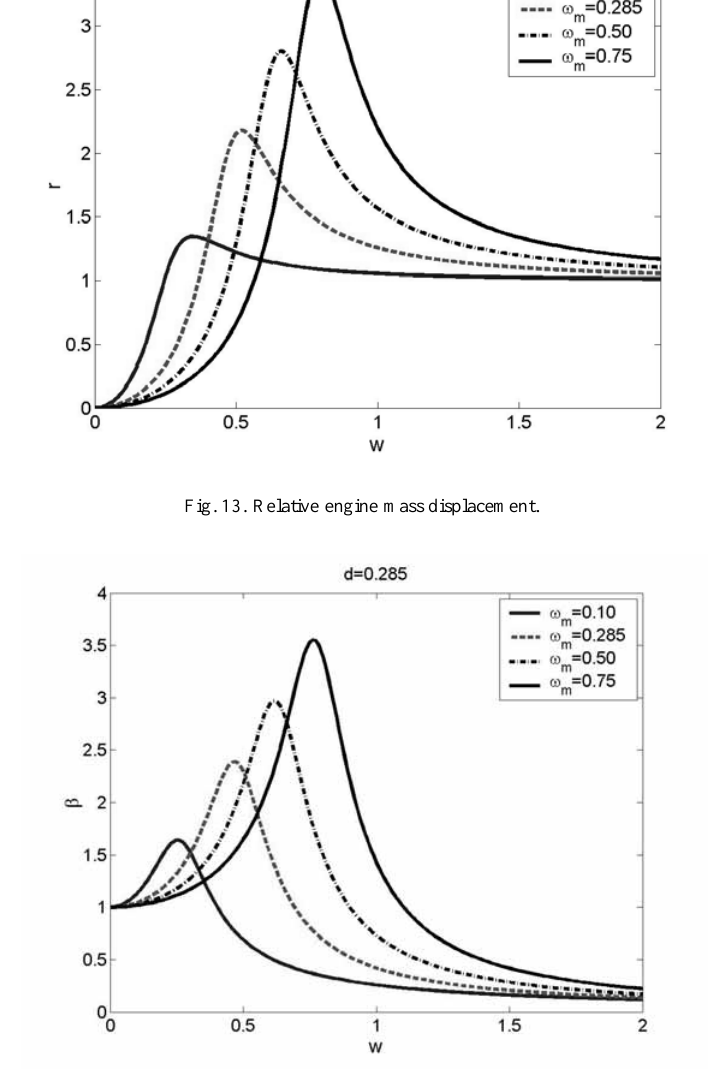
Fig. 14. Absolute engine mass